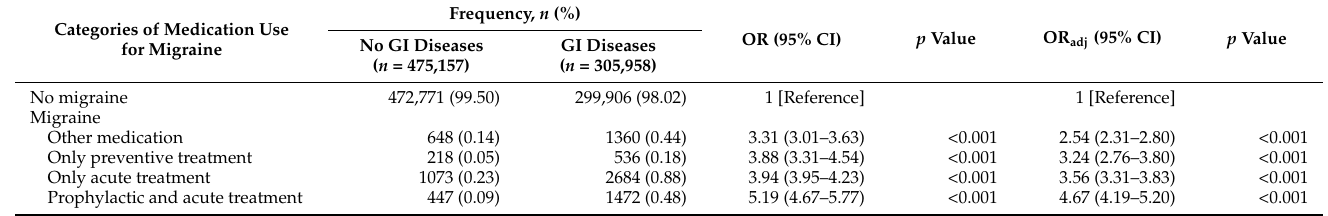
Table 4. The association between GI diseases and migraine by migraine medication